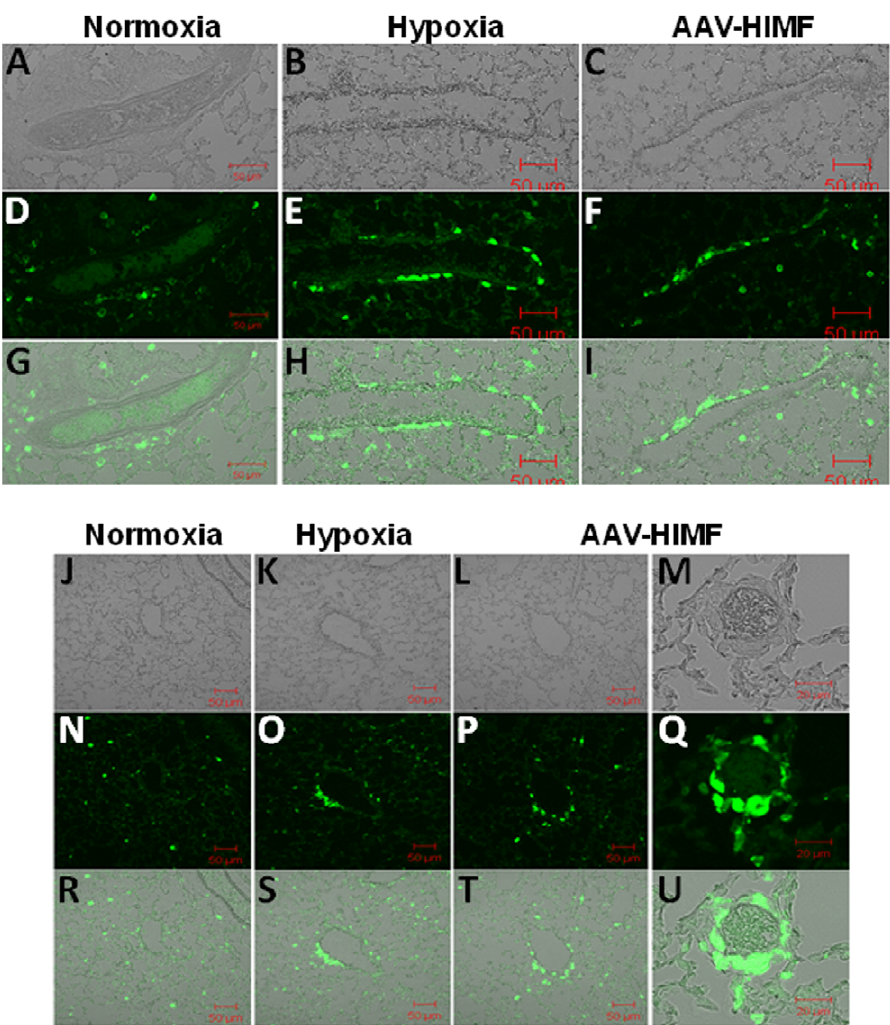
Figure 3. Both chronic hypoxia and pulmonary HIMF gene transfer recruit BMD cells to the pulmonary vasculature. (A–C, J–M) Light micrograph of fluorescence images to show blood vessel structure. Frozen sections from normoxic (20.8% O 2 ) (D, N), hypoxic (10.0% O 2 ) (E, O), and AAV-HIMF treated (2.5 6 10 10 VP) (F, P, Q) lungs were stained with a rabbit anti-GFP polyclonal antibody that was visualized by an FITC-conjugated goat anti-rabbit IgG antibody (green). (G–I, R–U): Differential interference contrast images of light and fluorescence images to show structure. A–L, N– P, R–T: Scale bar: 50 m m. M, Q, U: Scale bar: 20 m m.